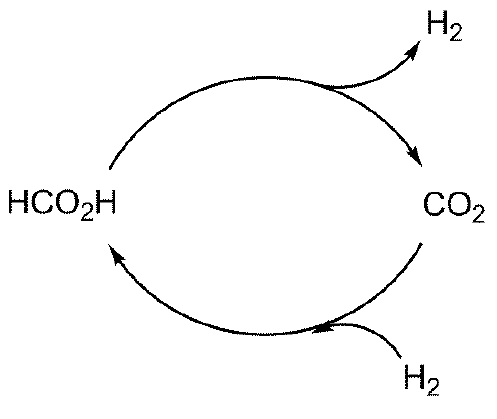
Figure 1. Hydrogen storage